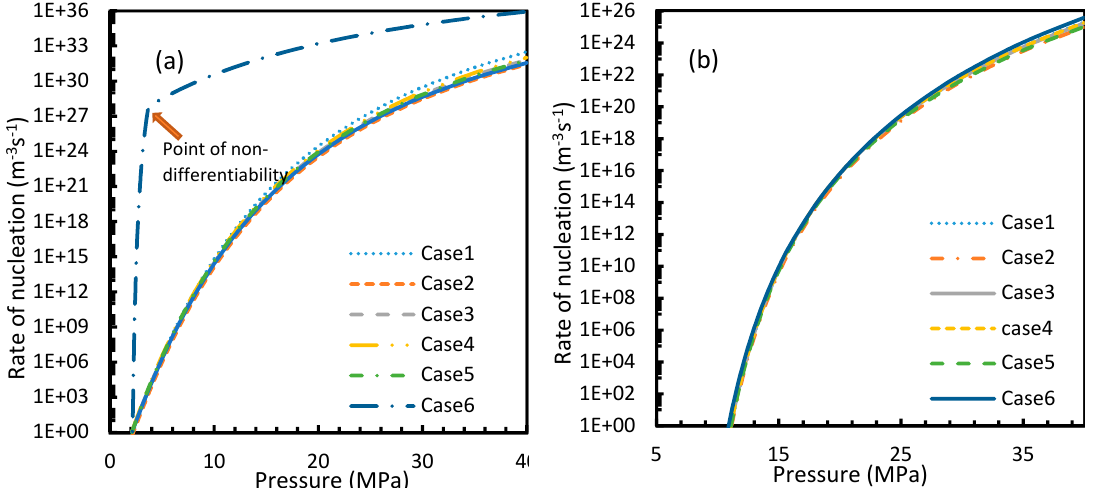
Figure 7. Profiles of nucleation rates of CO 2 ( a ) and CH 4 ( b ), under isothermal conditions with the reference temperature of 273.2 K. The profiles clearly show high rates of nucleation when CO 2 was used as the guest gas compared to when CH 4 was used. In addition, unlike the profiles of gas concentration in aqueous phase, the point of non-differentiability is shown only by Case 6.